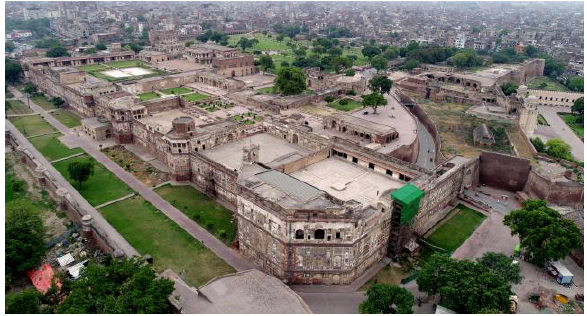
Figure 1. Drone image of The Lahore